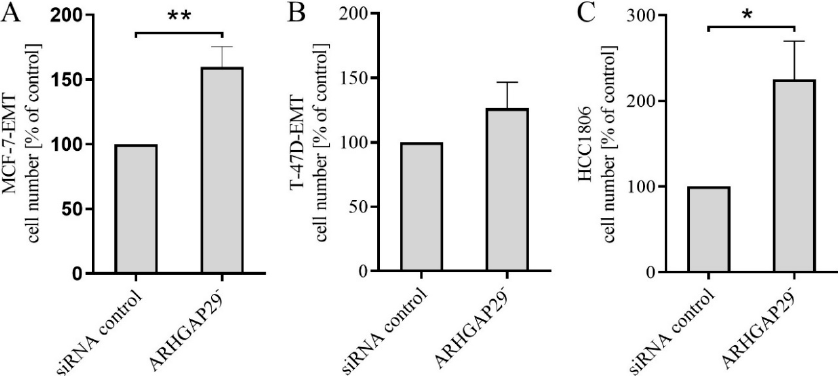
Figure 3. Effect of the downregulation of Rho GTPase activating protein 29 (ARHGAP29) on the proliferation of MCF-7-EMT ( A ), T-47D-EMT ( B ), and HCC1806 ( C ) breast cancer cells. Breast cancer cells were transiently transfected with ARHGAP29-specific siRNA or non-targeting control siRNA (control). After cell culture for 120 h, transiently transfected breast cancer cells were detached and counted using a Neubauer counting chamber. The number of cells in the treatment group was calibrated to the cell number in the control group using at least three biological and technical replicates. Mean ± SEM values are given. Significance was determined with the help of unpaired t- tests; (**) p < 0.01; (*) p < 0.05.